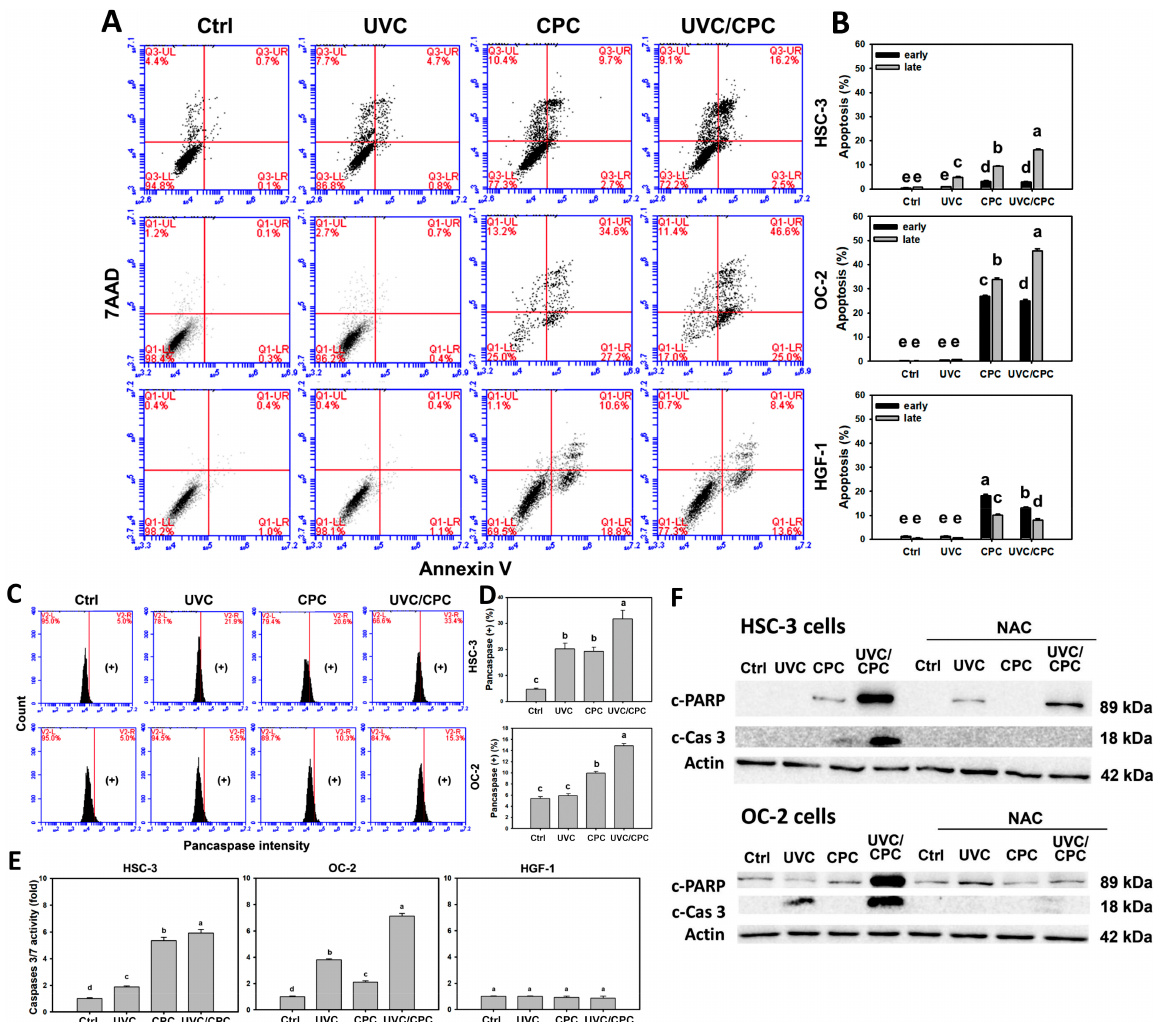
Figure 5. Apoptosis change of oral cancer and normal oral cells following UVC or/and CPC treat- ments. Cells were arranged to treat with vehicle control, UVC (10 J/m 2 ), CPC (5 µ g/mL), and UVC/CPC (10 J/m 2 and 5 µ g/mL). Flow cytometry, Cas 3/7 assay, and western blotting were performed after 24 h treatment. ( A ) Annexin V/7AAD patterns. Annexin V (+)/7AAD ( − ) and Annexin V (+)/7AAD (+) were counted for early and late apoptosis, i.e., + and – for high and low intensity. ( B ) Statistics for ( A ). ( C ) Pancaspase patterns. Pancaspase (+) populations were labeled with (+), i.e., high intensity. ( D ) Statistics for ( C ). ( E ) Cas 3/7 activity. Data, mean ± SD ( n = 3). Based on multiple comparisons after Tukey’s HSD Tests, different tests labeled without the same top letters differ significantly ( p < 0.05). ( F ) Western blotting analysis. Apoptotic signaling proteins (c-PARP and c-Cas 3) were detected. Except for NAC pretreatment (4 mM for 1 h), other treatments provided the same results described